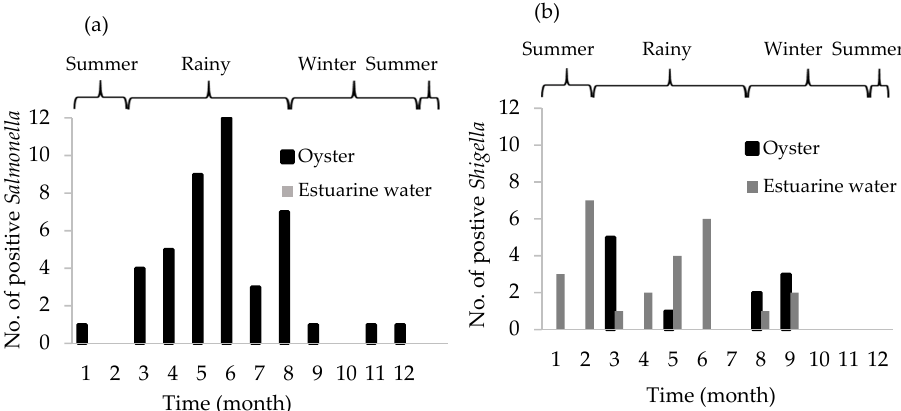
Figure 2. Number of positive samples for Salmonella spp. ( n = 44/144) and Shigella spp. ( n = 11/144): ( a ) The number of positive Salmonella samples; ( b ) The number of postitive Shigella samples of pooled oysters and estuarine water from Phang Nga Bay, southern Thailand. Sample collection started from March 2016 (month 1) to February 2017 (month